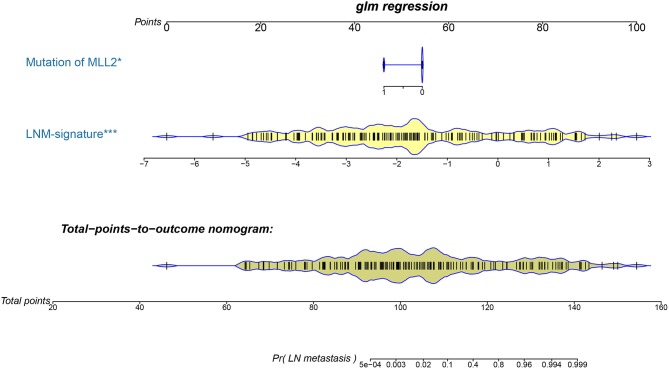
The developed pre-operative nomogram. The LNM nomogram was built in the training set of the TCGA cohort, with the LNM signature and genomic mutation of MLL2 incorporated.